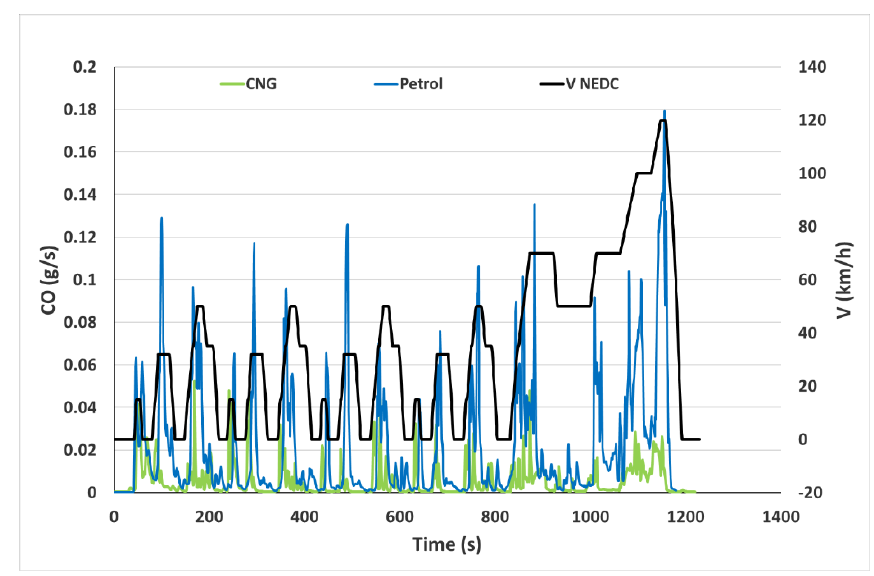
Figure 6. Comparison of CO emission between petrol and CNG propulsion in NEDC test.